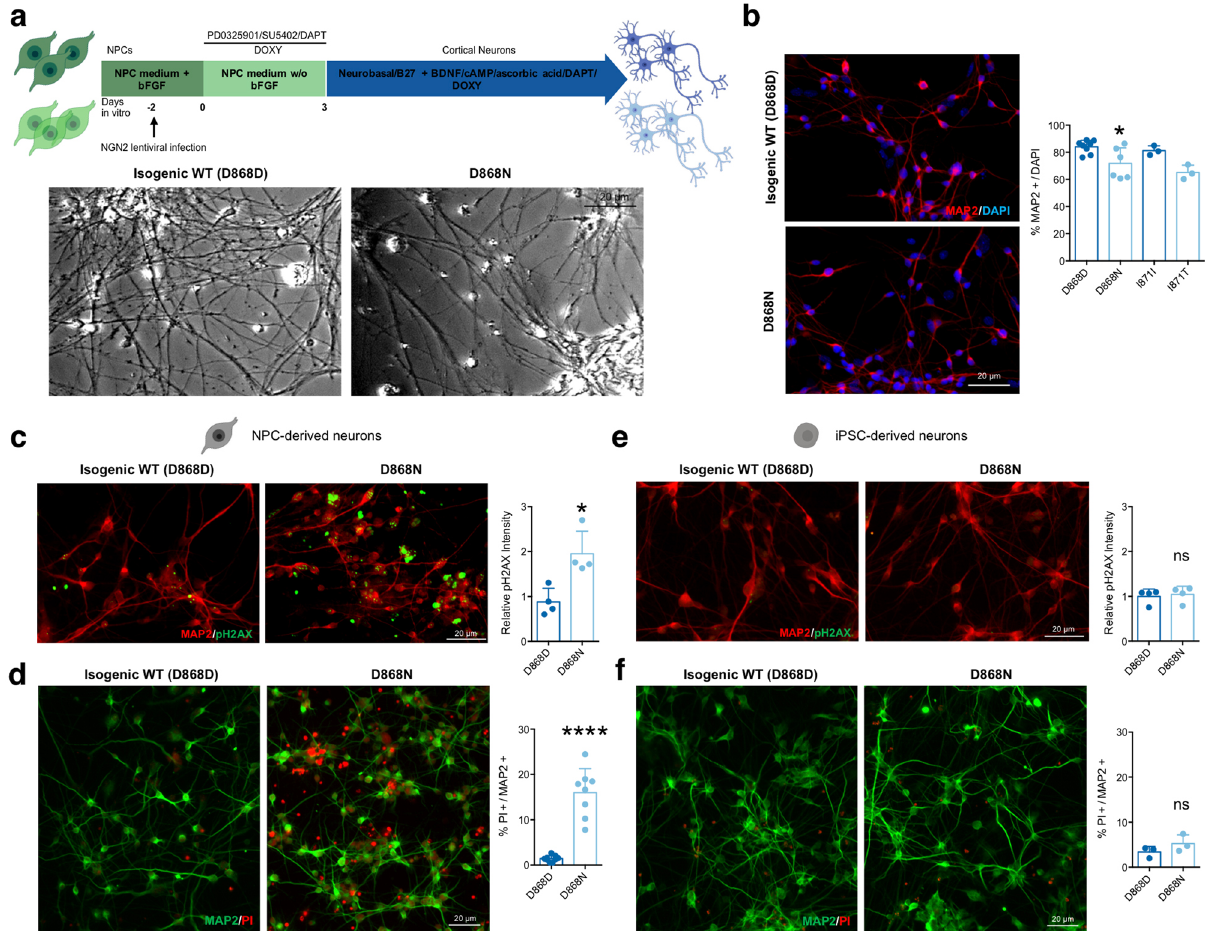
Fig. 7 SGS neurons inherit DNA damages and are prone to degenerate. a Scheme for NPC-derived neuronal differentiation protocol (upper panel) and representative bright- fi eld images (taken at the same magni fi cation) of isogenic control (D868D) and mutant (D868N) neuronal cultures (lower panel). b Representative images (taken at the same magni fi cation) of immunostaining for MAP2 (left) and relative quanti fi cation of isogenic control (D868D) and mutant (D868N) NPC-derived neuronal cultures. D868D vs. D868N * P = 0.0370; I871I vs. I871T P = 0.0768; D868N vs. I871T P = 0.5995. One-way ANOVA followed by Tukey post hoc test for multiple comparisons. n = 3. c Immunostaining and quanti fi cation for phosphorylated histone H2AX (pH2AX Ser139) in isogenic control (D868D) and mutant (D868N) NPC-derived neuronal cells. * P = 0.0107. Two-sided unpaired t test. n = 4. Images taken at the same magni fi cation. d Representative images (taken at the same magni fi cation) of immunostaining for MAP2 and PI and relative quanti fi cation of PI + over MAP2 + cells in isogenic control and mutant NPC-derived neurons. **** P < 0.0001. Two-sided unpaired t test. n = 8. e Immunostaining and quanti fi cation for phosphorylated histone H2AX (pH2AX Ser139) in isogenic control (D868D) and mutant (D868N) iPSC-derived neuronal cells. P = 0.7200. Two-sided unpaired t test. n = 4. Images taken at the same magni fi cation. f Representative images of immunostaining for MAP2 and PI and relative quanti fi cation of PI + over MAP2 + cells in isogenic control and mutant iPSC-derived neurons. P = 0.2337. Two-sided unpaired t test. n = 3. Images taken at the same magni fi cation. All data expressed as mean ± SEM. ns: nonsigni fi cant differences when P > 0.05; * P < 0.05, ∗∗∗∗ P < 0.0001. Analysis was performed at 4 weeks of neuronal